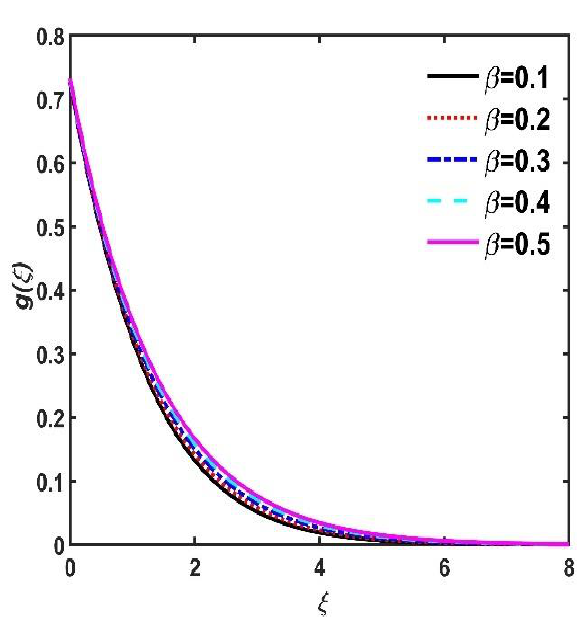
Figure 7. Impact of 𝛽 on 𝑔(𝜉) .